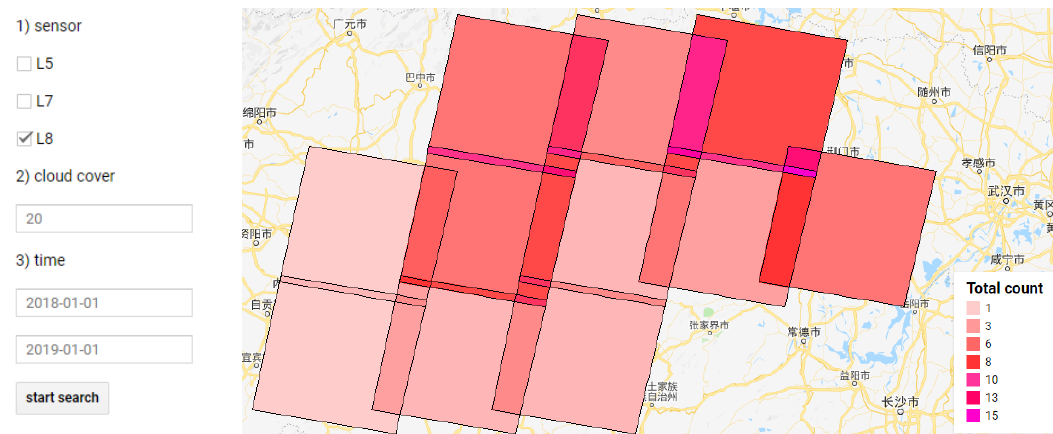
Figure 4. Yearly average of acquisition probabilities of Landsat TM, ETM+, and OLI historical data (10876 scenes) at 10%, 20%, and 30% CC thresholds over TGRA between 1986 and